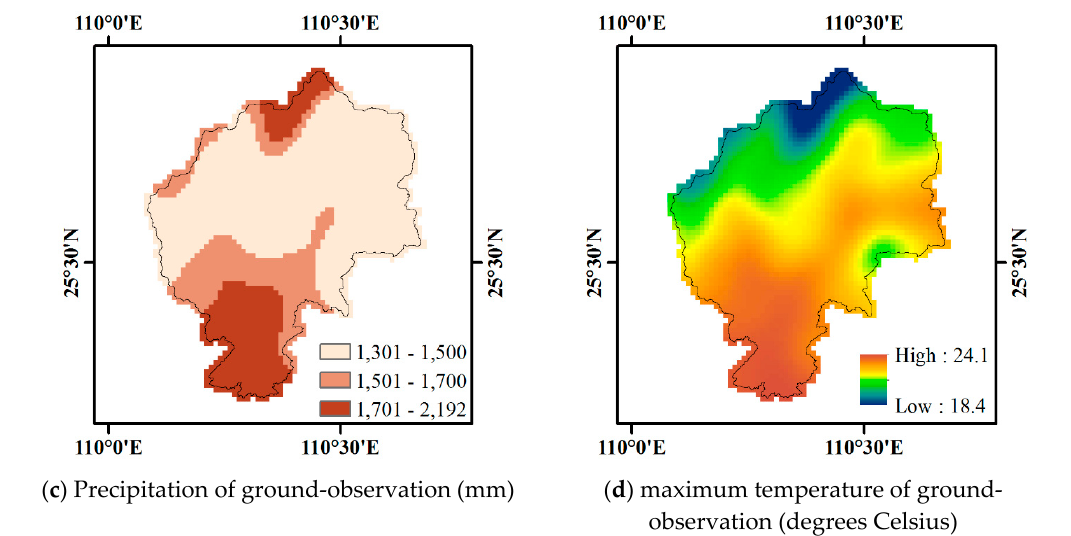
Figure 2. Spatial distribution of annual precipitation and maximum temperature estimation.